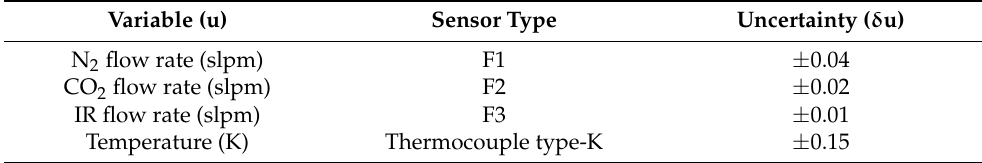
Table 1. Determination of accuracy of measuring sensors.